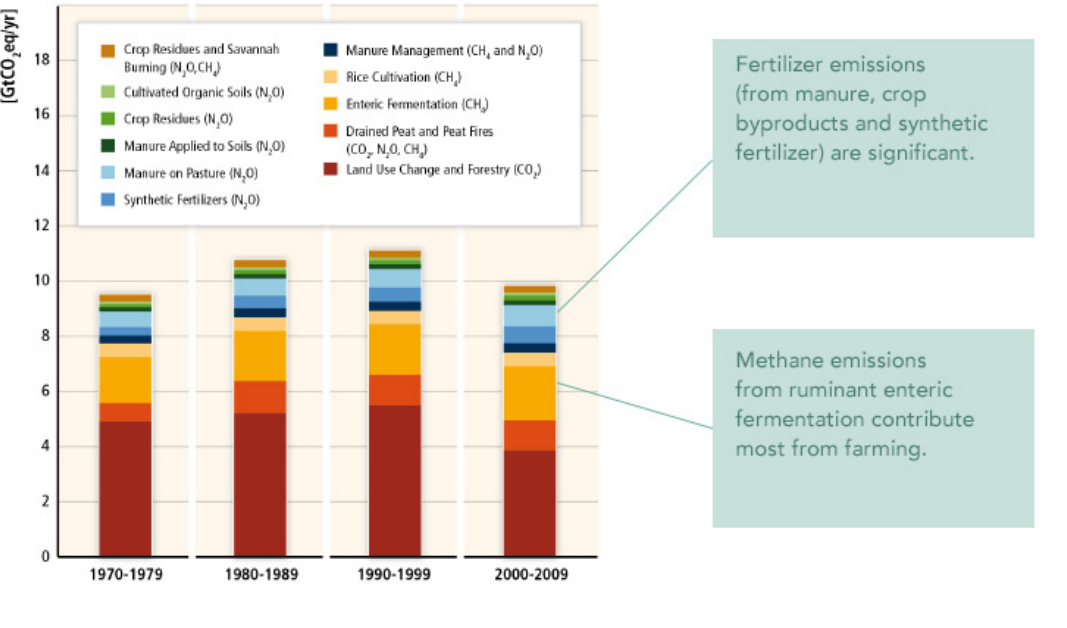
Figure 5: The contribution of livestock to agricultural greenhouse gas emissions. Source: Smith P., et al.